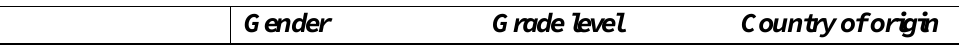
Significance of Interactions between Characteristics of Science Questions and Characteristics of the Research